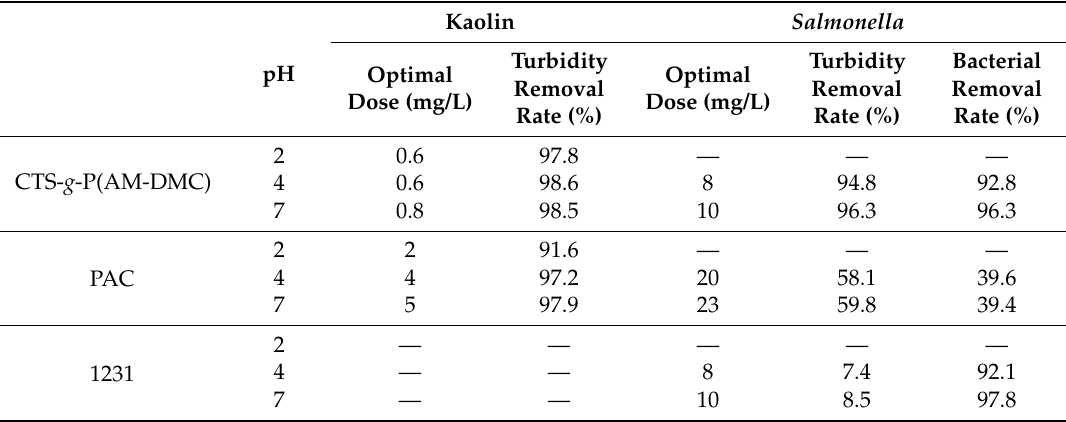
Table 2. Flocculation performance of CTS- g -P(AM-DMC), PAC, and 1231 at different pH.